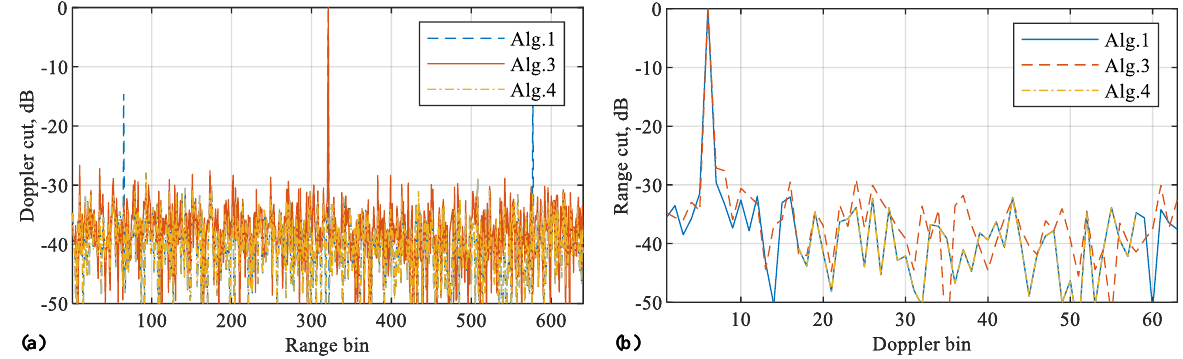
Figure 5. ( a ) Doppler cuts of the RDMs shown in Figure 4; ( b ) range cuts of the same RDMs. Note that Algorithm 1 as developed in [32], is simulated as a benchmark. It suffers from the false target issue. In contrast, the new algorithms, Algorithms 3 and 4, are able to remove the false targets. Please note that the symbol “-” before all numbers, as automatically generated by MATLAB during plotting the figure, denotes the negative